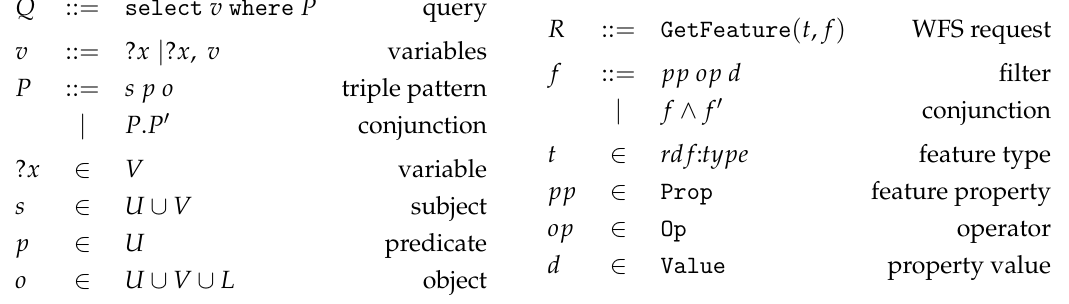
Figure 2. Syntax of SPARQL queries and the corresponding WFS